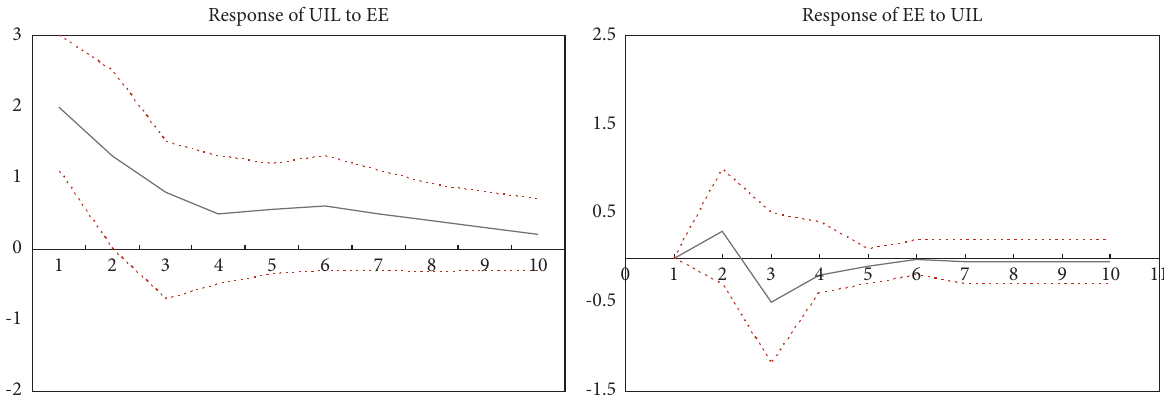
Figure 5: Impulse response of urban innovation level and ecological